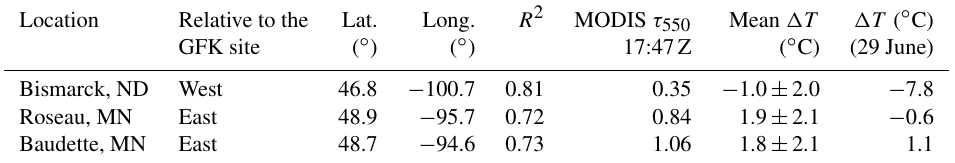
Table 3. The monthly mean differences ( (cid:49)T ) as well as correlations in the observed daily maximum temperatures between Grand Forks, ND (GFK) and three ASOS site: Bismarck, ND (west of GFK), Roseau and Baudette, MN (east of GFK) for 15 June–14 July 2015, excluding 29 June 2015. The daily maximum temperature differences ( (cid:49)T ) between GFK and other three ASOS sites on 29 June 2015 are also reported. Also included are the latitude, longitude of the three ASOS sites and estimated τ 550 values from MODIS (17:47UTC, 550nm). Location Relative to the Lat. Long.